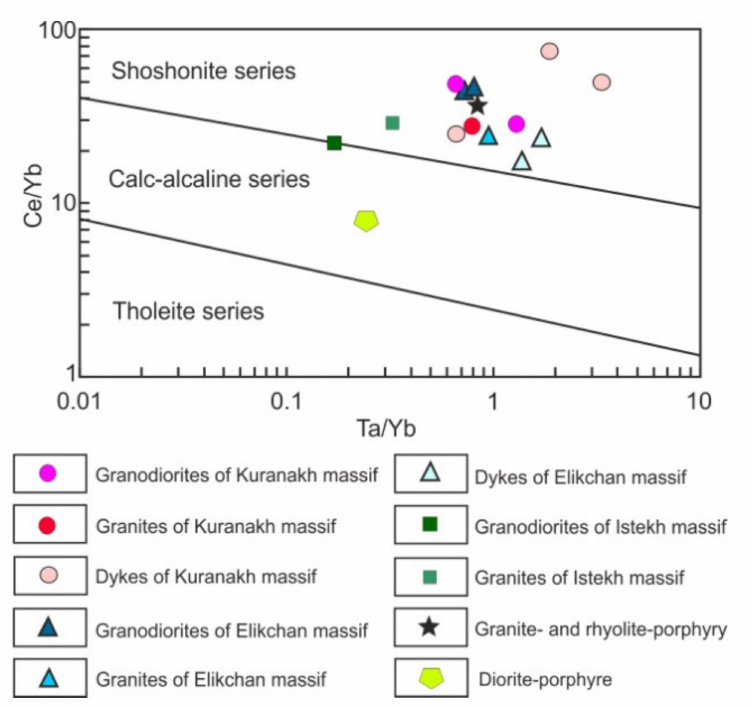
Figure 13. Ce/Yb vs. Ta/Yb diagram. Field definitions are derived from [93]. The highest Au contents are present in granitoids of the Kuranakh massif (Table